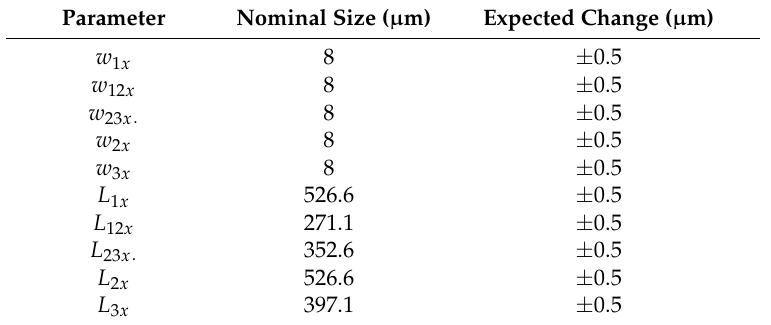
Table 4. Different parameter perturbations which could affect the robustness of the proposed gyroscope.